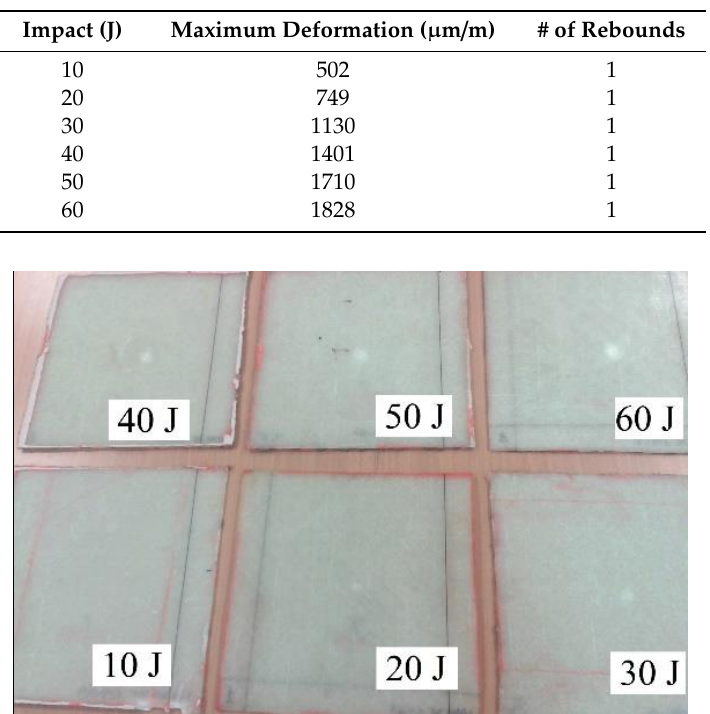
Table 2. Variables used in unmodified panels for vertical weight drop tests.